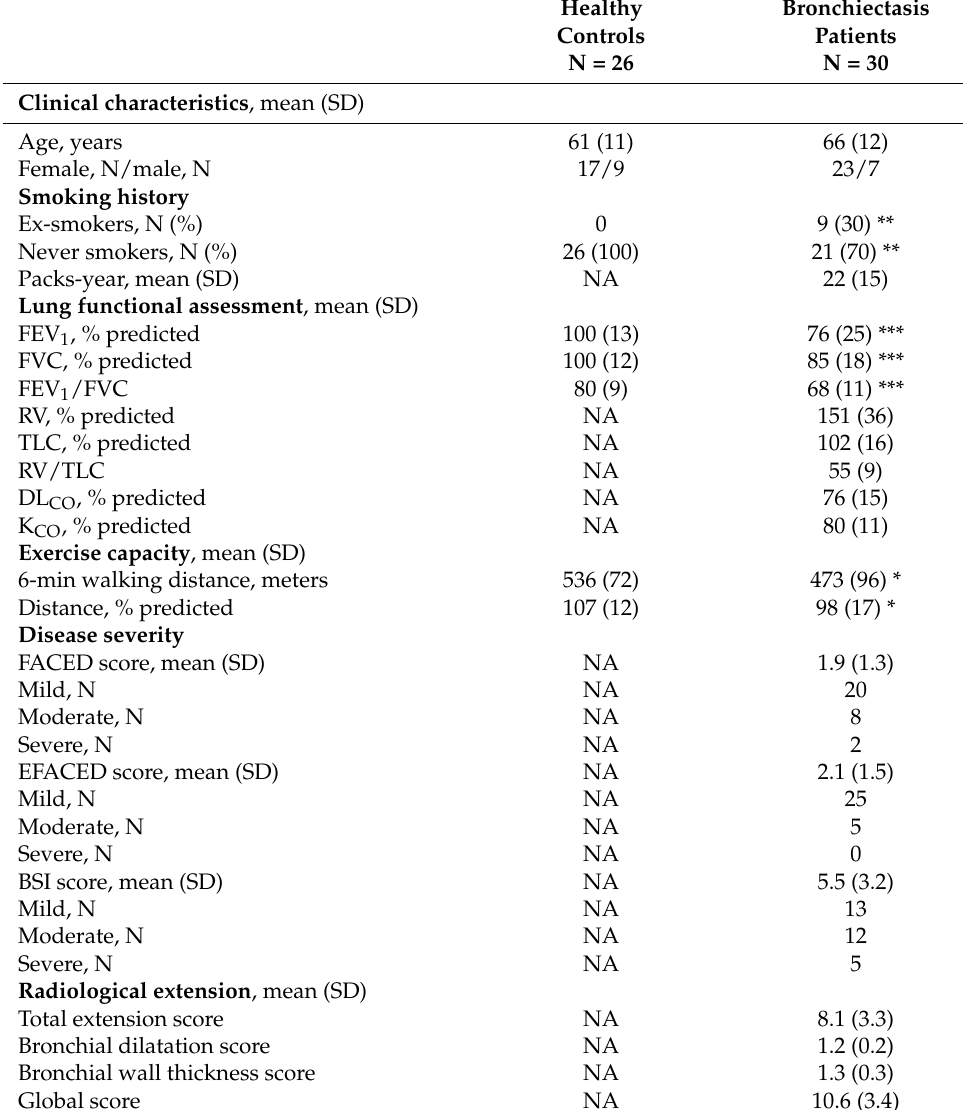
Table 1. Clinical characteristics in bronchiectasis patients and healthy